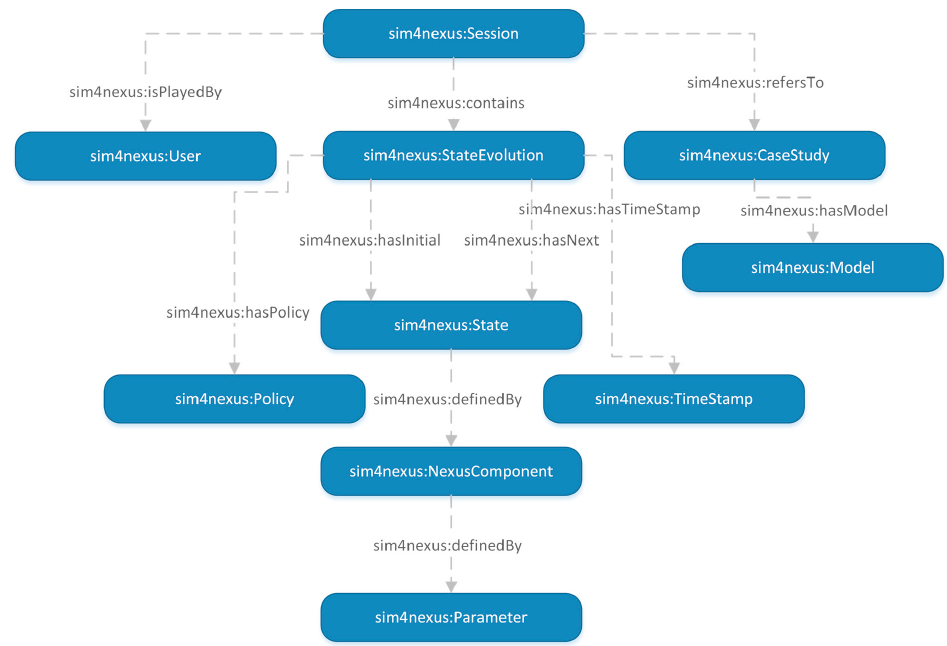
Figure 5. Simplified ontology schema for the Sardinia fast-track. See the text for details.